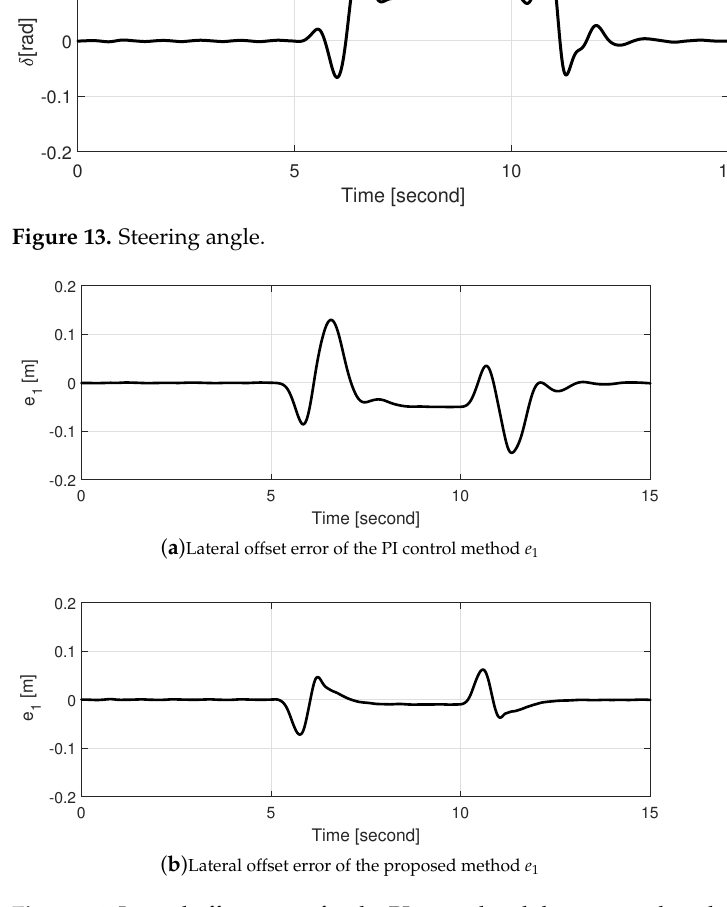
Figure 15. Vehicle trajectory of the proposed method